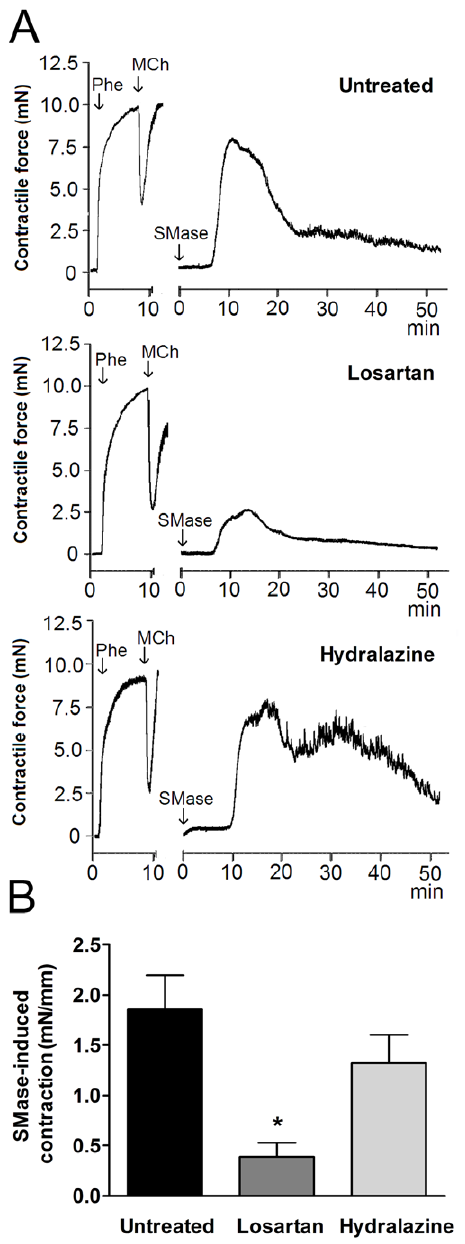
Figure 4. Losartan, but not hydralazine, reduces ceramide- mediated endothelium-dependent contractions in isolated carotid arteries of SHR. ( A ) Typical tracing of 0.1 U/mL sphingomy- elinase (SMase)-induced endothelium-dependent contraction in carotid arteries of untreated, losartan-treated and hydralazine-treated SHR. ( B ) Quantification of peak ‘‘EDCF-mediated contractile responses’’ to SMase. Data are expressed as mean 6 SEM, n=7–8, * p , 0.05 compared to untreated